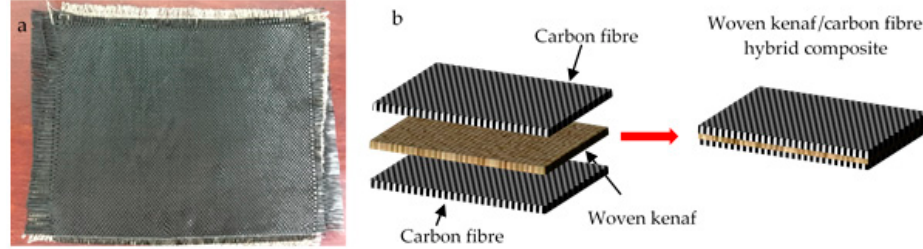
Figure 2. ( a ) Carbon fibre and ( b ) Three-layered woven hybrid composite sample prepared using vacuum infusion